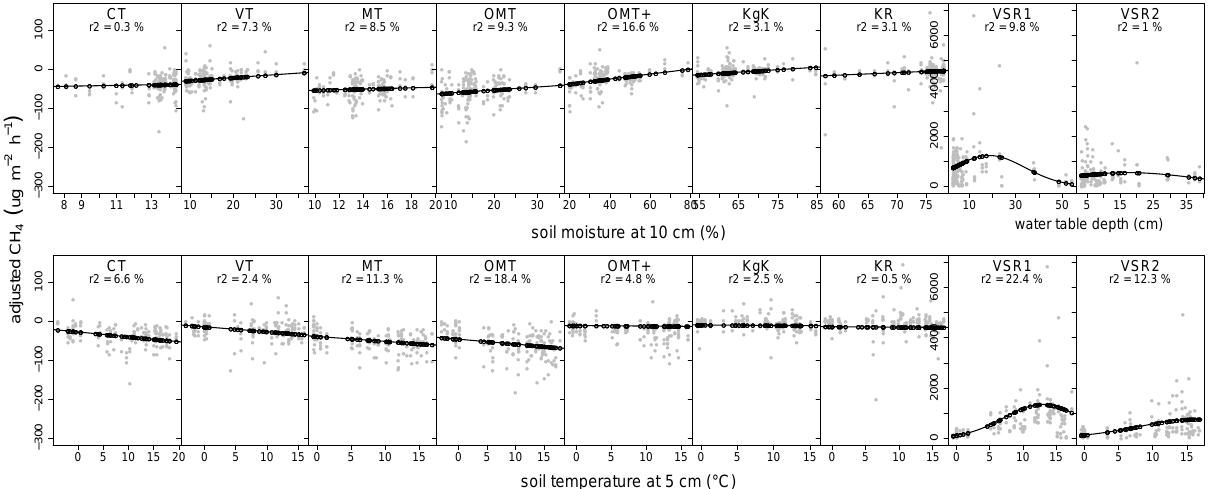
Figure 4. Comparison of sensitivity of forest floor CH 4 fluxes (µgm − 2 h − 1 ) to environmental factors for nine forest/mire types. Modeled in the upper panels is CH 4 flux response to soil moisture at 10cm (uplands and transitions) or to water table depth (cm) (mires) for uplands (CT, VT, MT, OMT) Eq. (1), for transitions (OMT + , KgK, KR) Eq. (2), and for mires (VSR1, VSR2) Eq. (3). Water table depth is indicated as negative when it is above the soil surface. In the lower panels, CH 4 flux response (Eqs. 1–3) is modeled to soil temperature at 5cm of the same forest/mires types and during the same period as in the upper panel. The CH 4 flux response for each individual environmental factor is illustrated so that the simulated value for each data point was recalculated by allowing only one factor at a time to vary while the other was set to its mean level. To the adjusted CH 4 flux responses (black points) the corresponding residual of each data point was added in order to describe the unexplained model variation (gray points). The r 2 (%) is the proportion of explained variance. The left–right arrangement of sites mimics the locations on the slope (see Fig. 1).